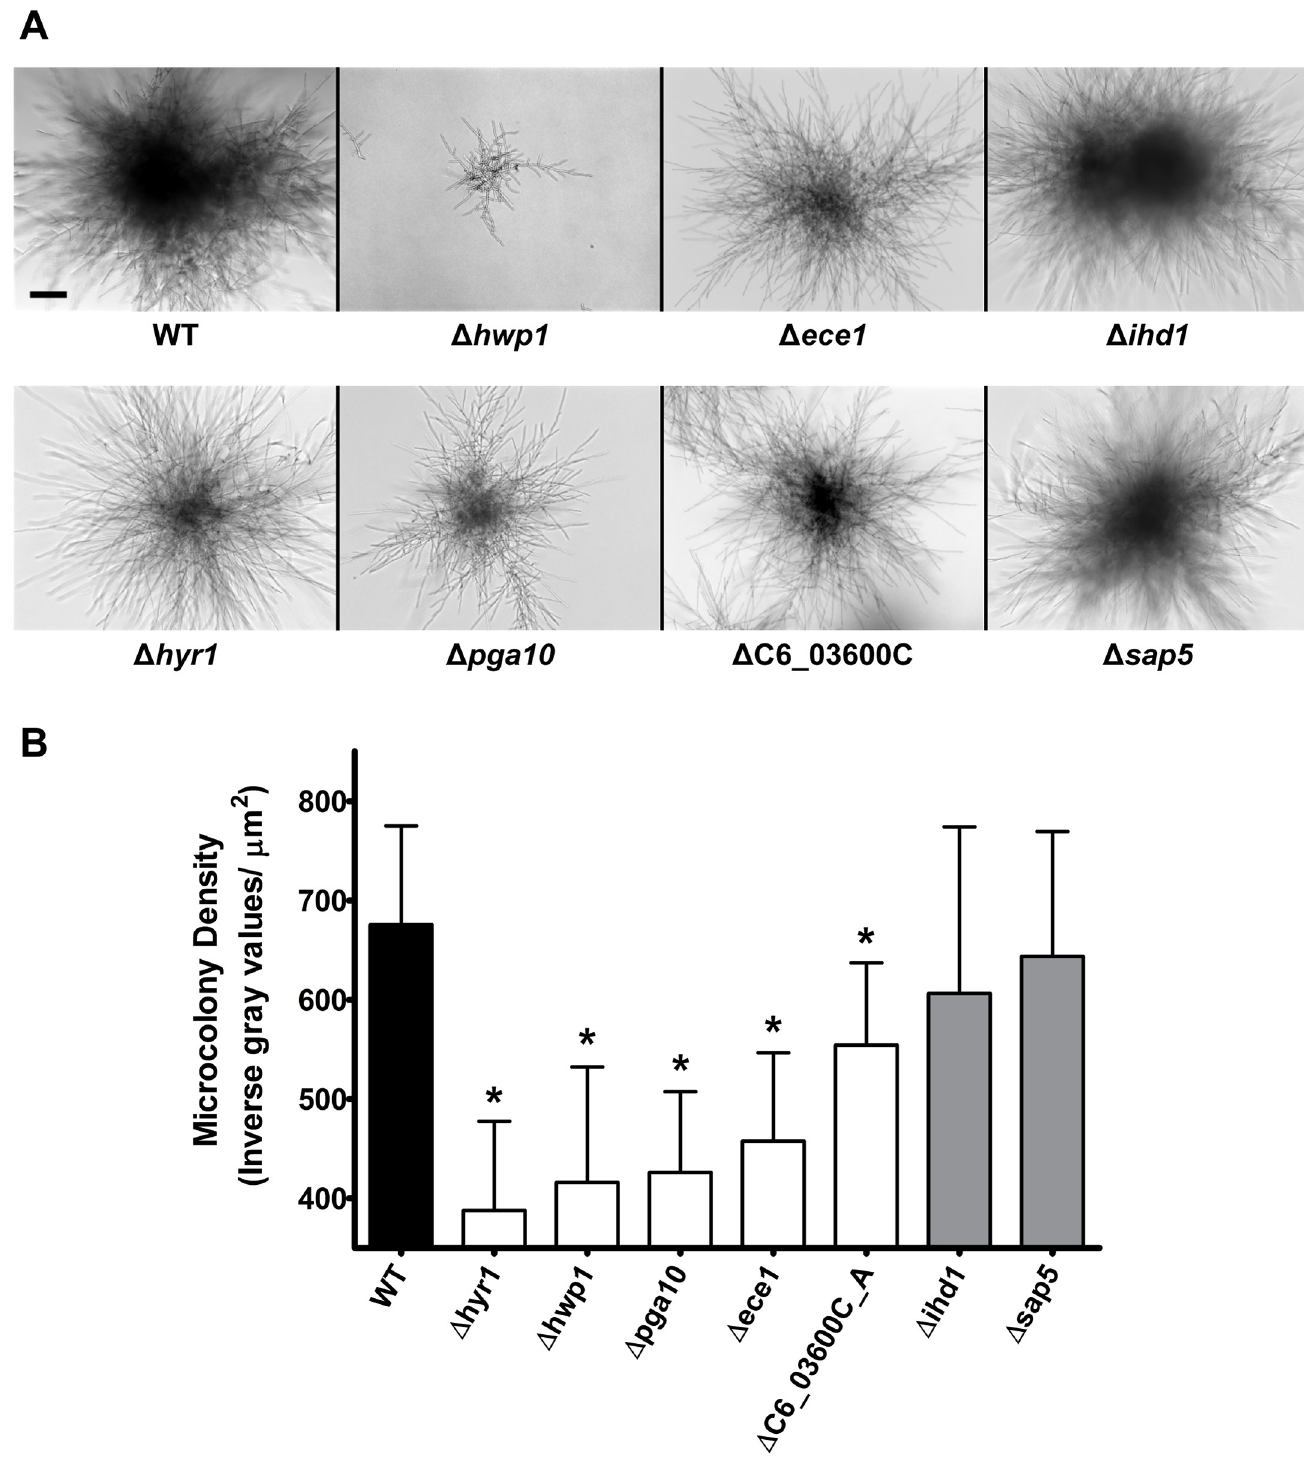
Fig 4. Five core microcolony genes are essential for microcolony formation. ( A ) Homozygous knockout mutants and wild type CAI4 cells were grown under static microcolony inducing conditions (RPMI with 5% CO 2 ) for 20 h, and imaged using brightfield microscopy. Scale bar indicates 100 μm. ( B ) Microcolony density per square micron was evaluated for each strain using ImageJ. Data are means ± SD of n (cid:21) 3 experiments, with (cid:3) indicating significance by a post-hoc Tukey’s test at p < 0.05 as compared to WT.